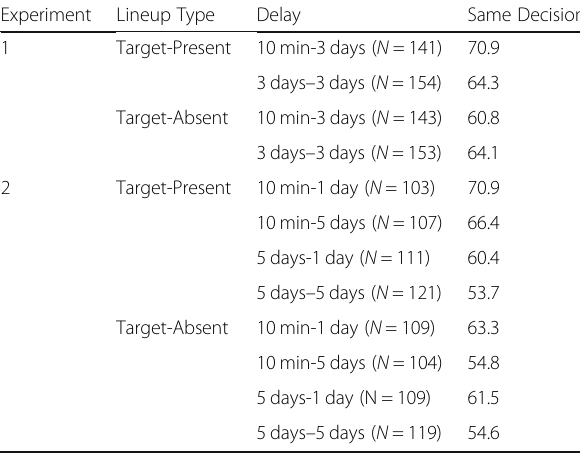
Table 1 Experiments 1 and 2: Percentages of Same and Different Decisions across Lineup 1 and 2